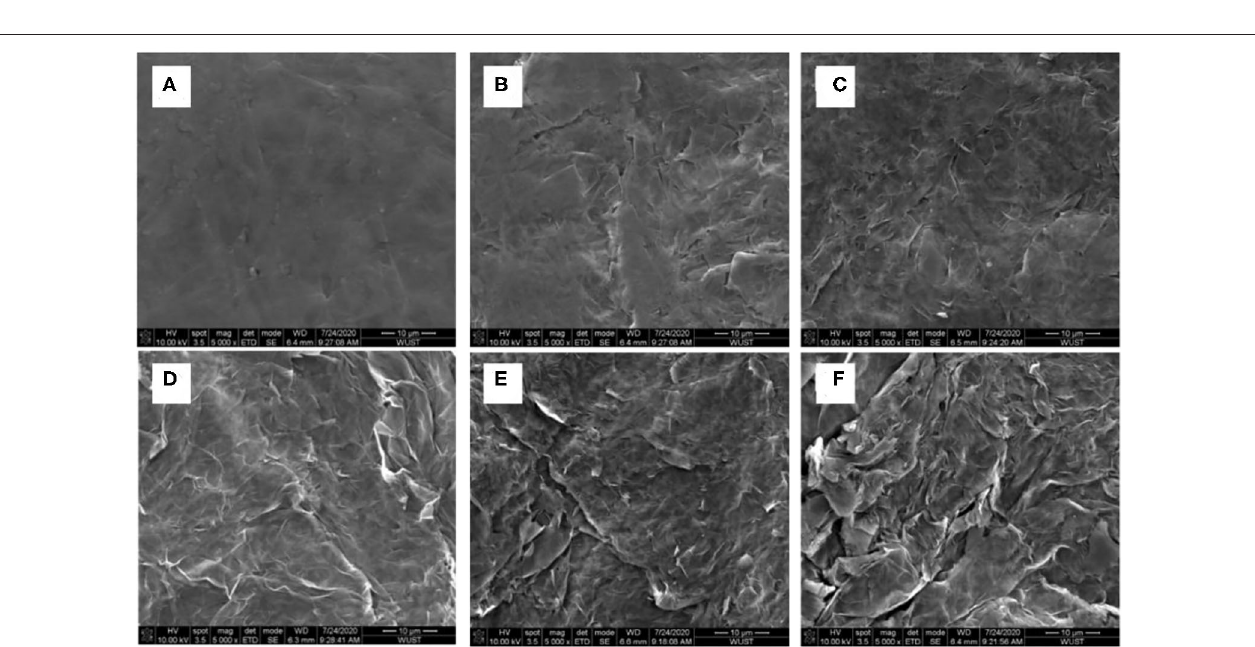
FIGURE 4 | SEM images of (A) pristine graphite paper, (B) S1, (C) S2, (D) S3, (E) S4, and (F) S5.